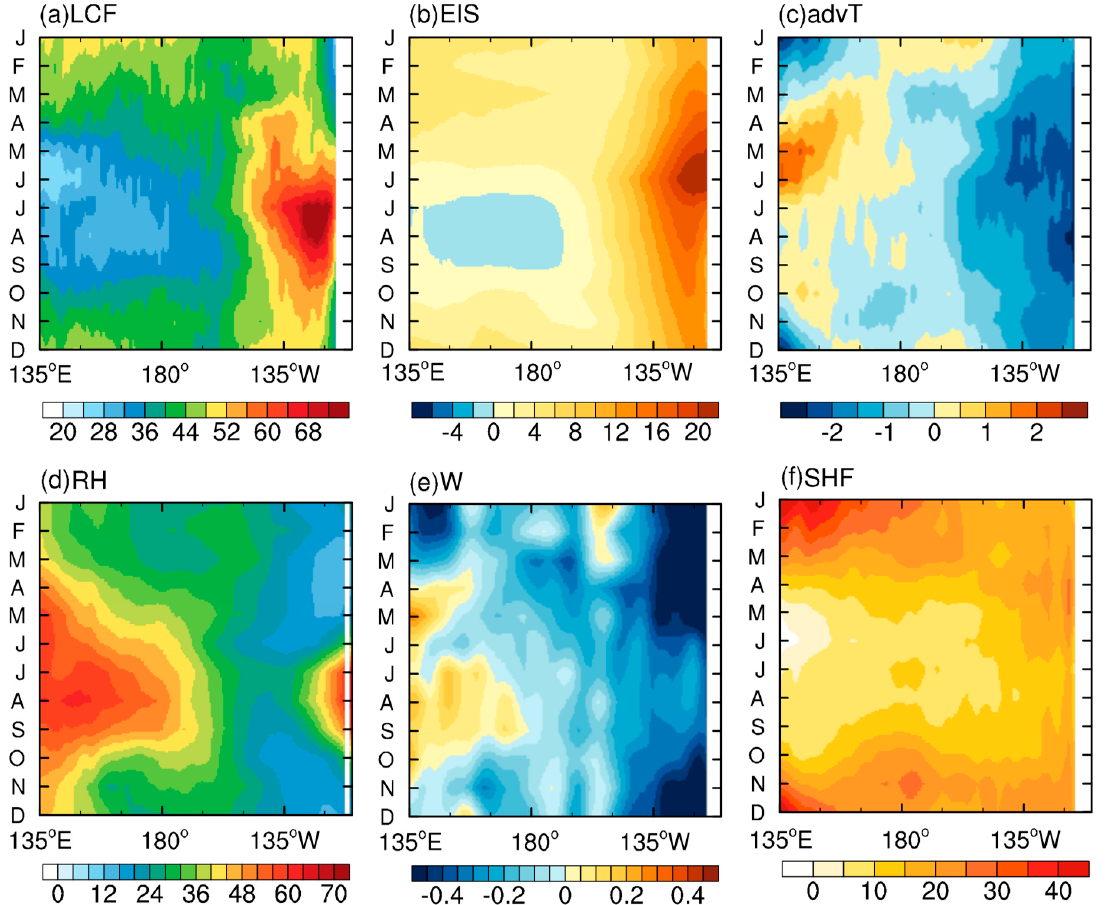
Figure 2. Time-longitude section of climatological ( a ) LCF (shading; units: %), ( b ) EIS (shading; units: K), ( c ) near-surface temperature advection (advT; shading; units: K/day), ( d ) 700-hPa relative humidity (RH; shading; units: %), ( e ) 700-hPa subsidence (W; shading; units: m/s), and ( f ) sensible heat flux (SHF; shading; units: W/m 2 ) along 25° N.